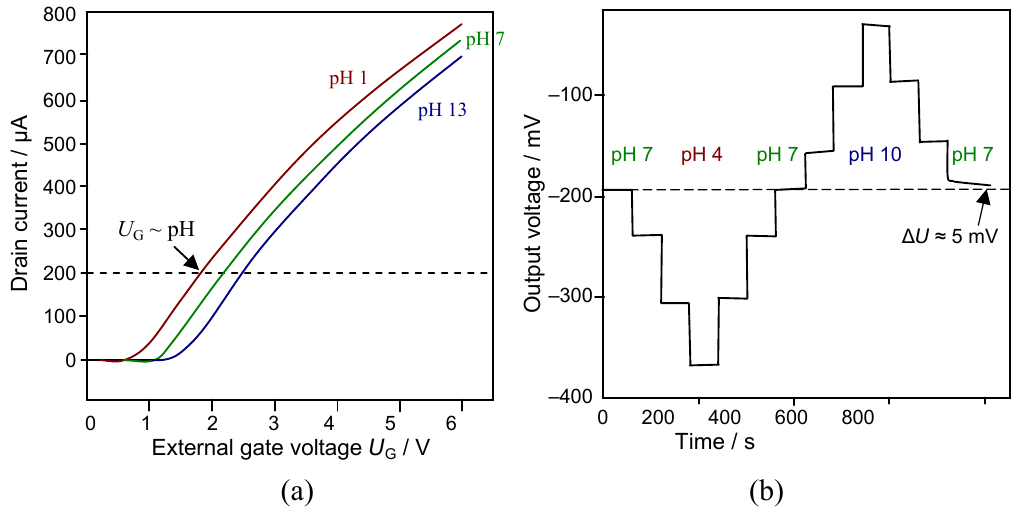
Figure 3. (a) ISFET transfer characteristics at different pH at 25 ° C. The gate is coated thin film. (b) Hysteresis widths during the pH 7–4–7–10–7 loop cycle with a RuO 2